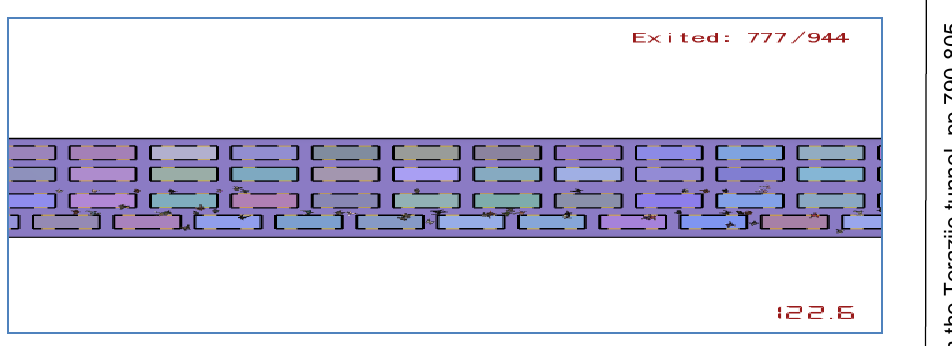
Figure 8 – Simulation example for the first scenario after 122.6 seconds from the start of the simulation